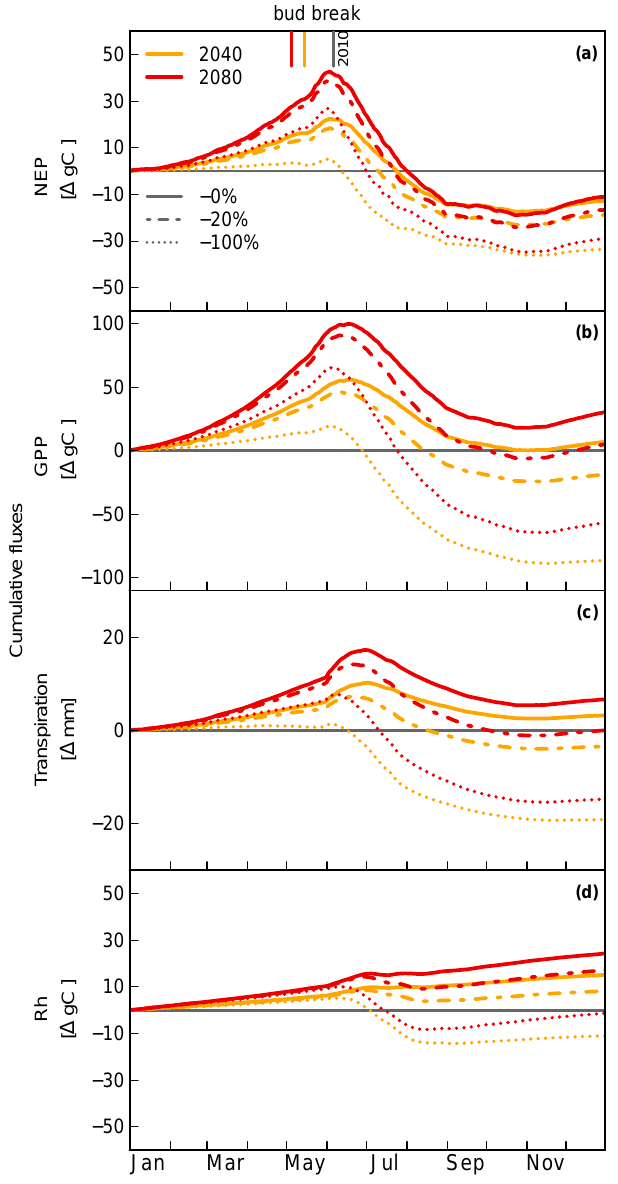
Figure 7. Seasonal course of anomalies in cumulative fluxes un- der future climate scenarios vs. 2010/11 conditions. Future scenar- ios are 2040 (June–Aug: +3 ◦ C, September–May: +2 ◦ C) and 2080 (June–August: +4.5 ◦ C, September–May: +3 ◦ C) with 0%, 20% or 100% rain reduction during summer. The timing of bud break under the 2010/11, 2040 and 2080 simulations are depicted by the vertical lines. Note that CO 2 concentrations were 390 ppm for all